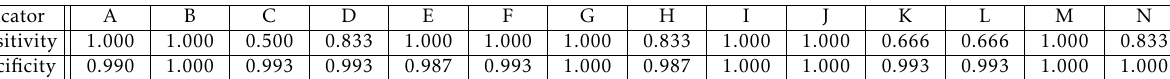
Table 1. Sensitivity and specificity of the individual indicators are calculated. Variable